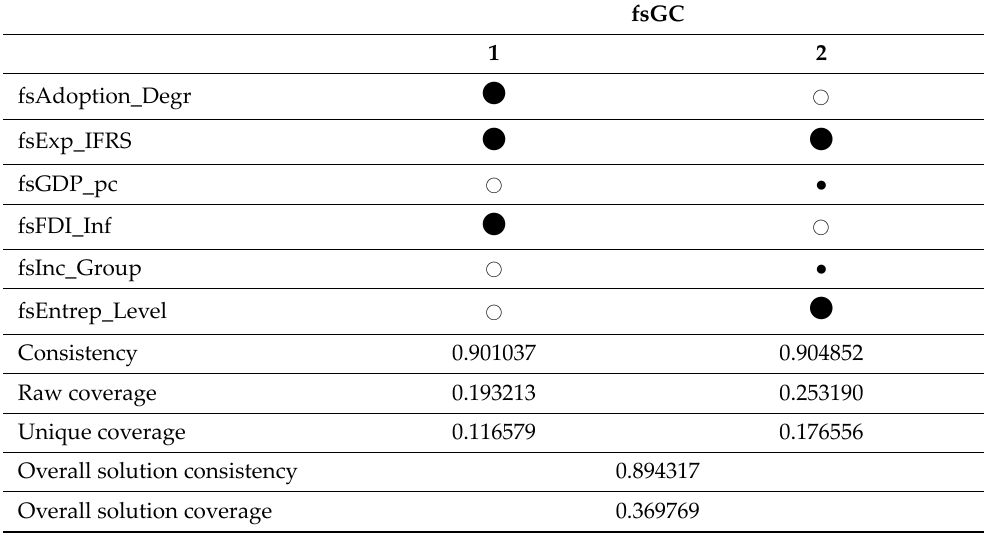
Table 8. Solution from fsQCA: configurations for achieving high GC scores — Model 2a . fsGC